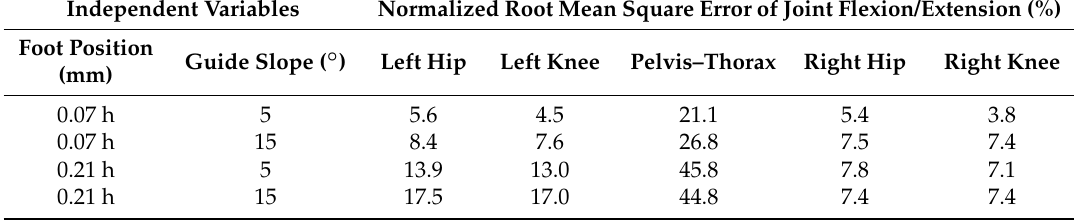
Table 7. Pearson correlation coefficients of captured and synthesized joint angles (*: p < 0.001).